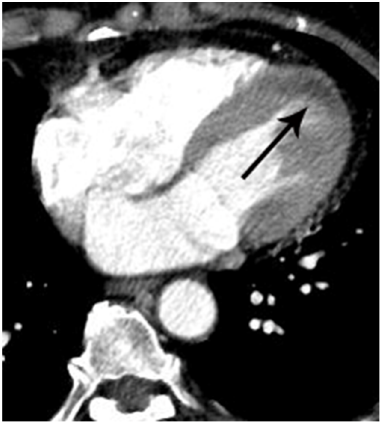
Figure 5. False positive myocardial perfusion defect (MPD) in a 55-year-old female with acute chest pain. Focal low attenuation (arrow) in the left ventricular apex was noted on an axial CT image. The lesion was given a CT score of 2 for MPD. However, serial ECG and serum cardiac troponin were normal, and her final diagnosis was reflux esophagitis.